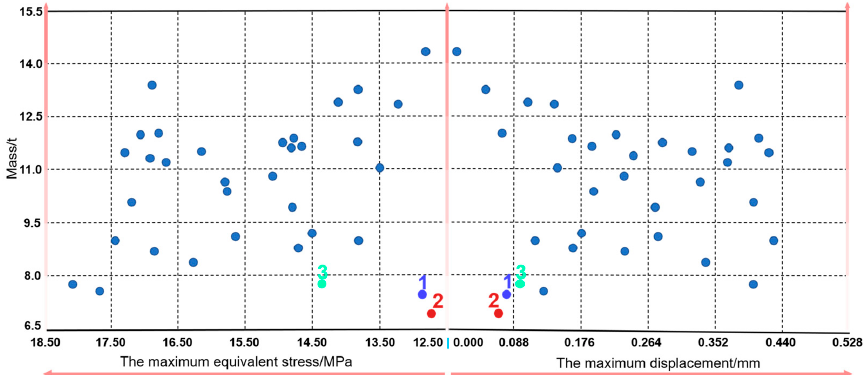
Figure 5. Scatter diagram of the generative cross joints.